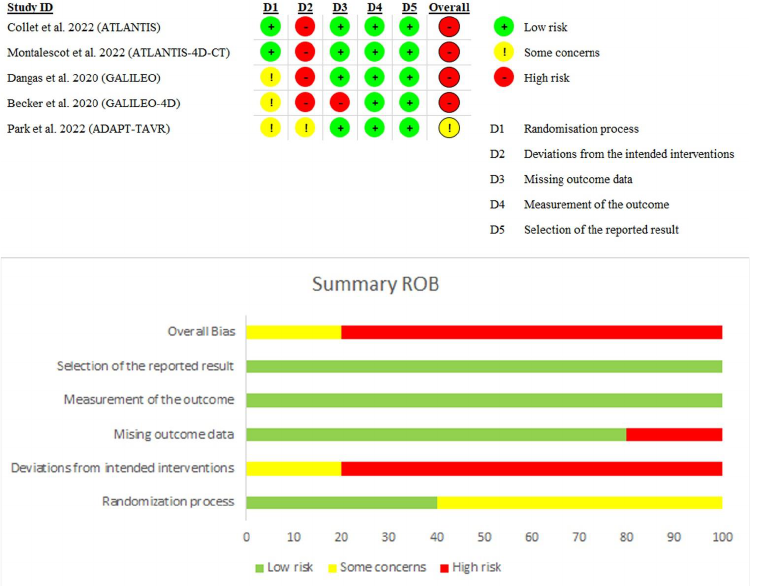
Figure 2. Quality assessment of risk of bias in the studies. The upper panel [5–9] presents a schematic representation of risks (low = green, unclear = yellow, and high = red) for specific types of biases of each of the studies. The lower panel presents risks (low = green, unclear = yellow, and high = red) for the subtypes of biases of the combination of studies included in this review.